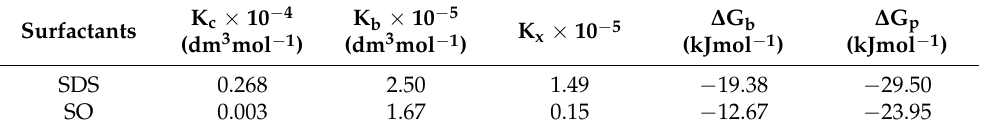
Table 1. Partition constant, K c, partition coefficient, K x , binding constant (k b ), Gibbs energy of partition, ∆ G p and Gibbs energy of partition, ∆ G p for Co 2+ in SDS and SO systems. Surfactants